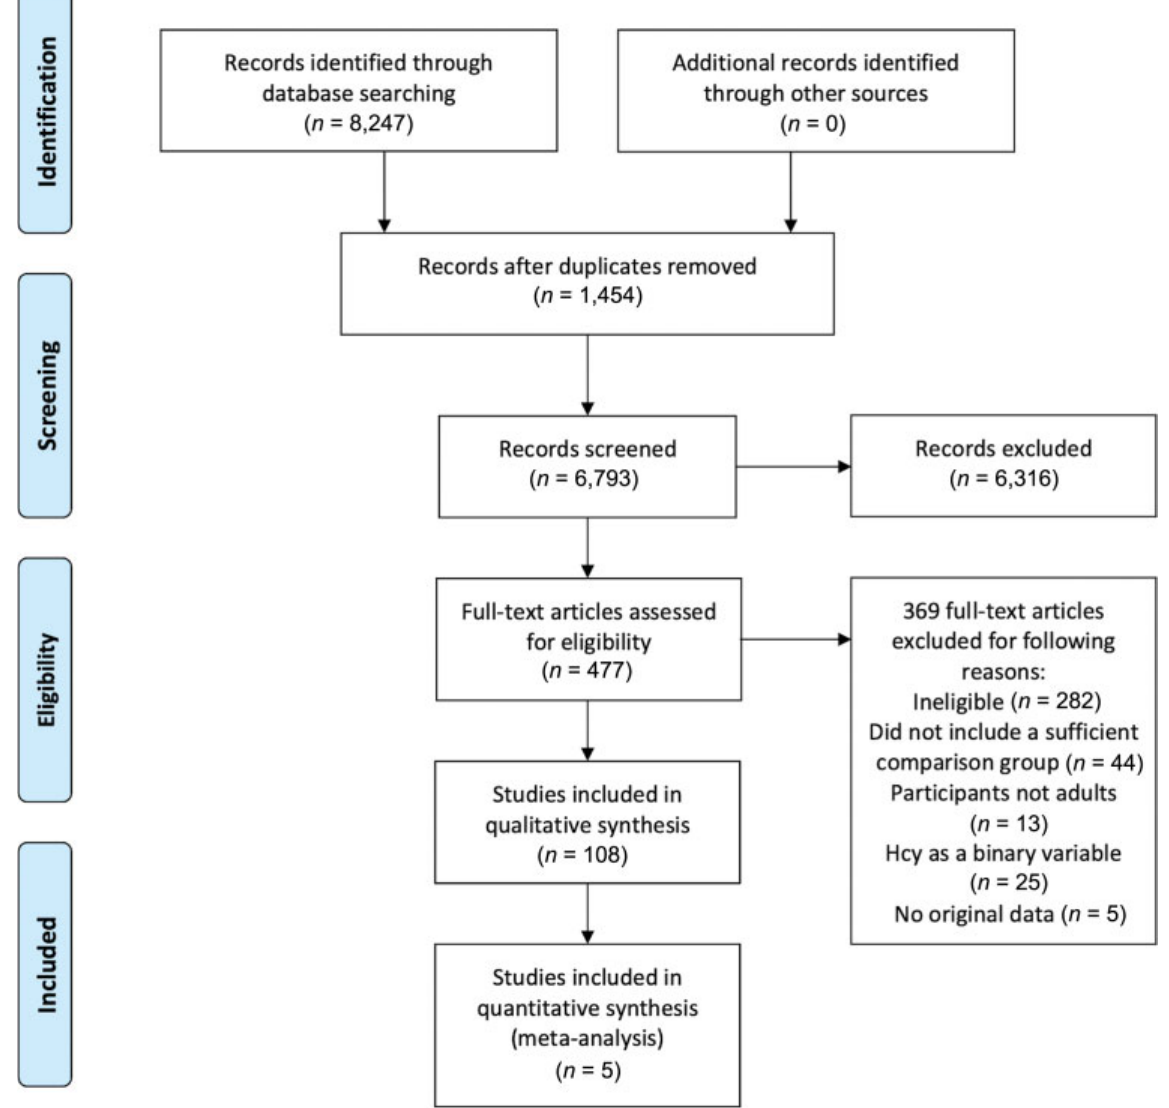
Fig. 1 Preferred Reporting Items for Systematic Reviews and Meta-Analyses (PRIMSA) fl ow diagram.